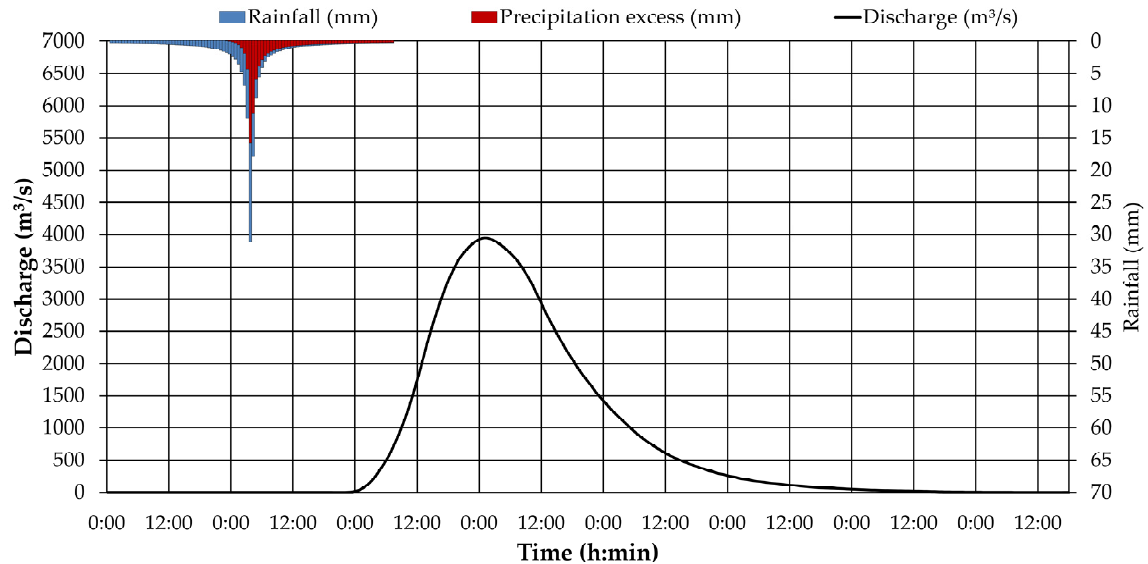
Figure 4. Event based simulation results for rainfall duration of 48 h and return period of 50 years.